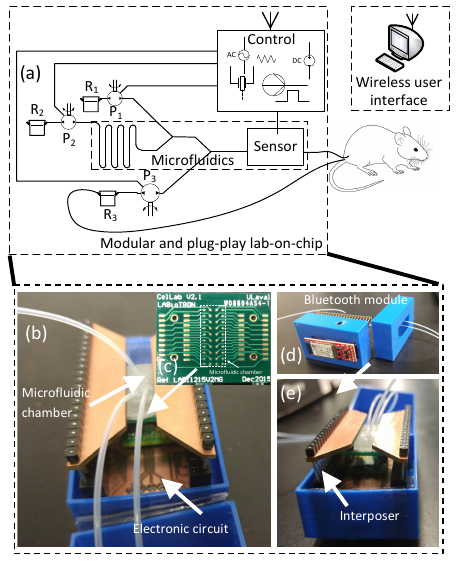
Figure 2. A three-channel potentiostat implanted on PCB. Each channel is designed to detect one molecule (serotonine, dopamine 1 or dopamine 2). The input signal (V stim ) is shared between all potentiostats. V out is the measured